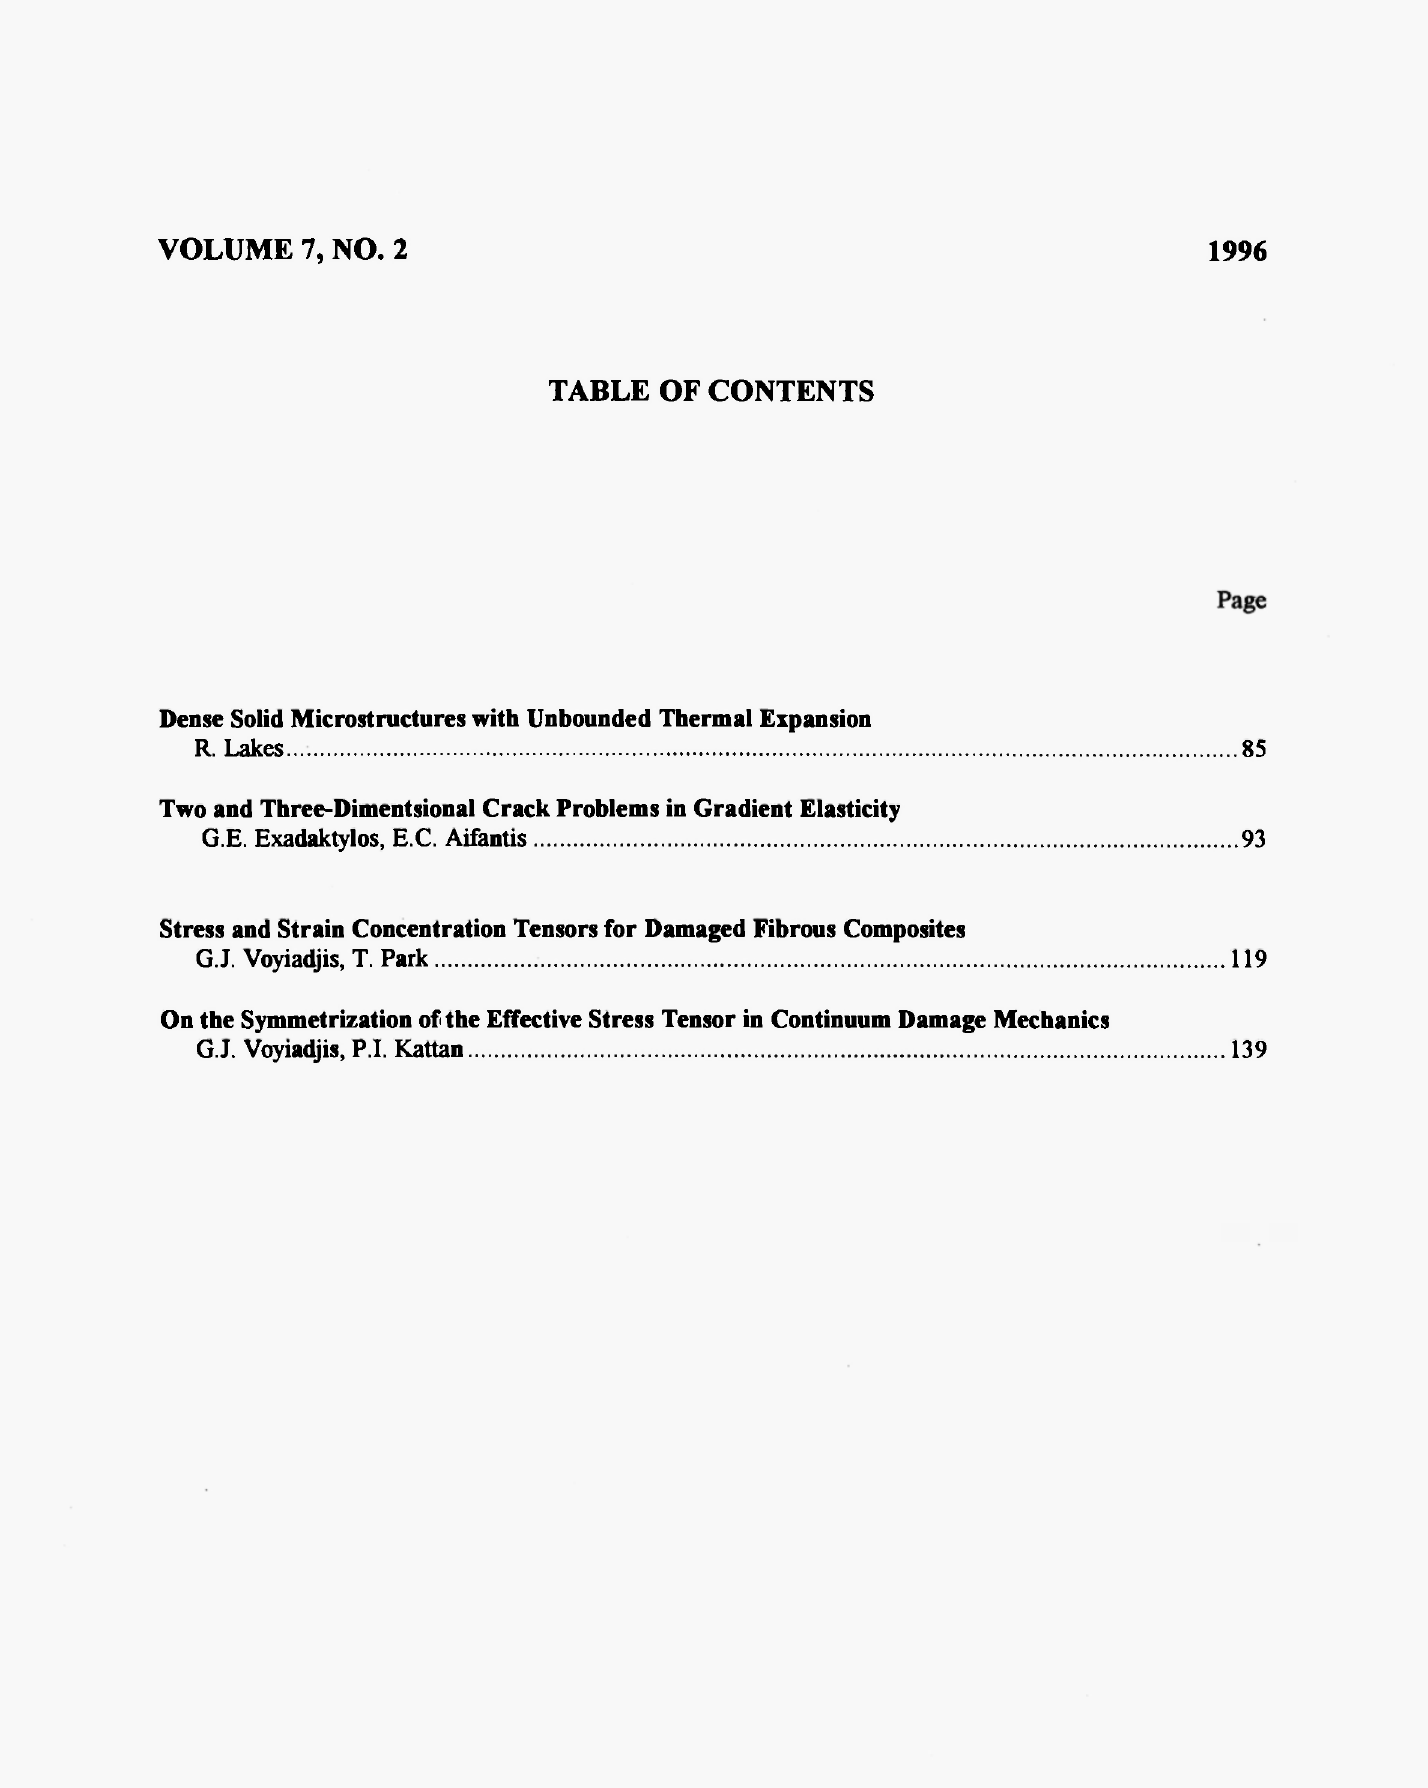
Dense Solid Microstructures with Unbounded Thermal Expansion R. Lakes Two and Three-Dimentsional Crack Problems in Gradient Elasticity